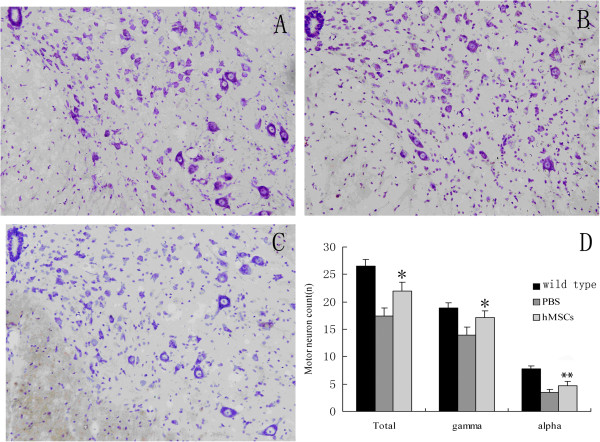
Attenuation of neuronal loss by intrathecal administration of human marrow stromal cells. Cresyl violet staining of the lumbar spinal cord sections from 15-week-old wild-type mice (A) and Cu/Zn superoxide dismutase 1 (SOD1) transgenic mice treated with PBS (B) and human marrow stromal cells (hMSCs) (C) at 200× magnification. (D) Quantitative cell counts of motor neurons in the anterior horn sections. Intrathecally injected hMSCs significantly preserved motor neuron loss in SOD1 transgenic mice at the age of 15 weeks (*P <0.01and **P <0.05 versus PBS alone).